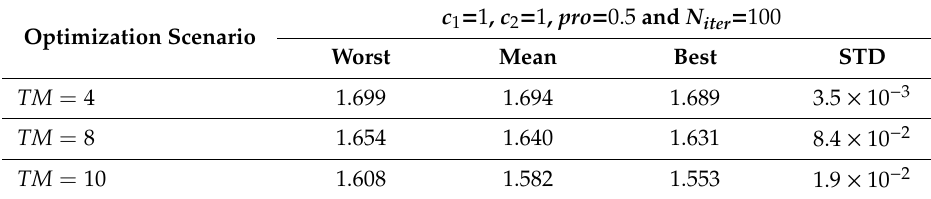
Table 9. Comparison under di ff erent values of TM : IAE criterion.